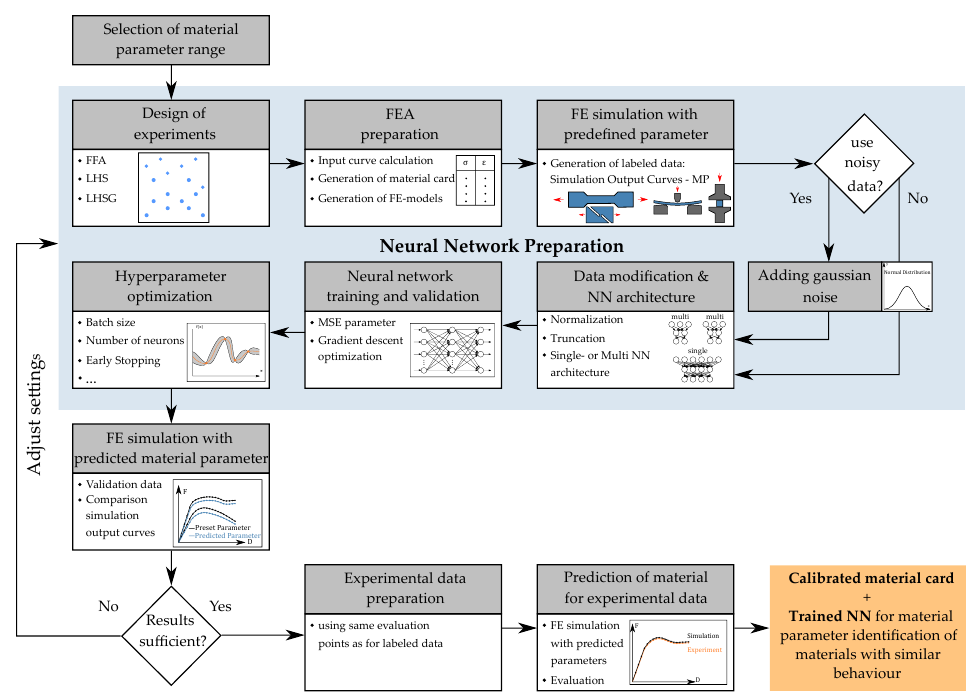
Figure 9. Workflow of the used direct NN-based parameter identification procedure applied to the problem of identifying the defined material parameters for MAT_187_SAMP-1 and MAT_ADD_DAMAGE_GISSMO